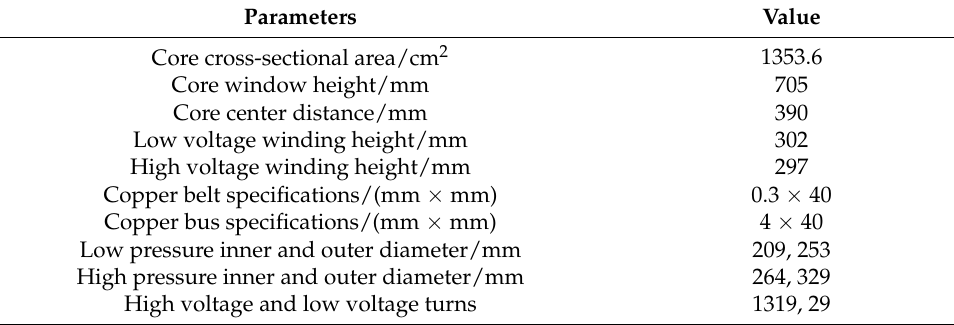
Table 1. Parameters of the simulation